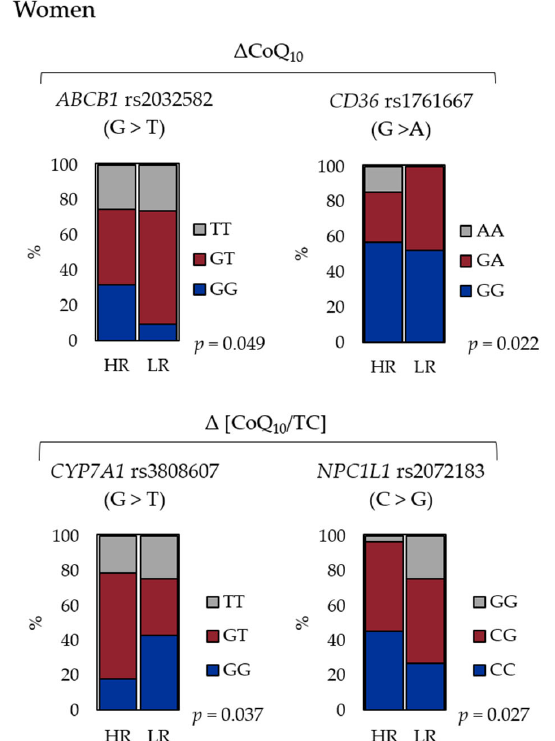
Figure 3. Genotypic frequency of the SNPs identified as correlated with the high-responders/low-